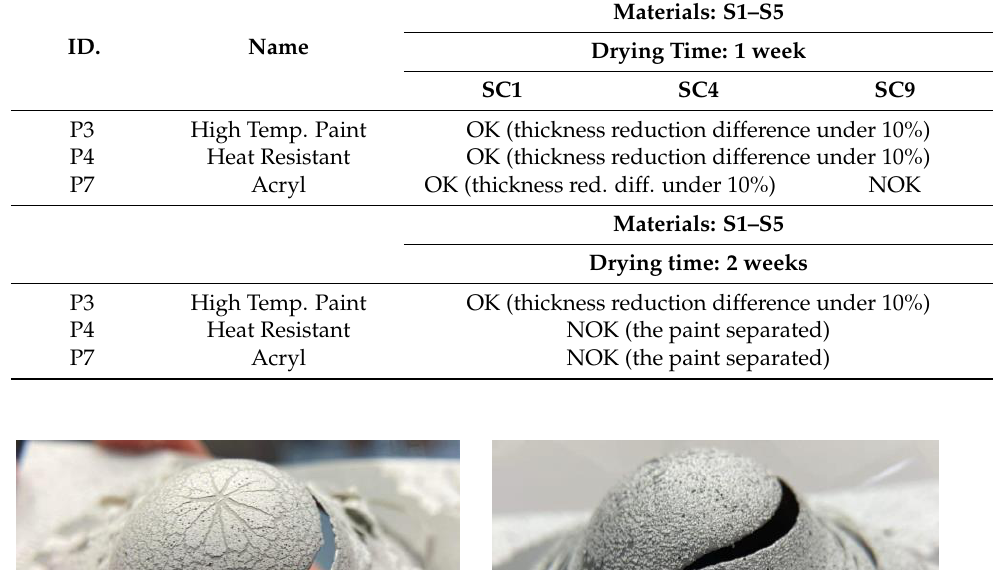
Table 15. Certification results of usability tests.